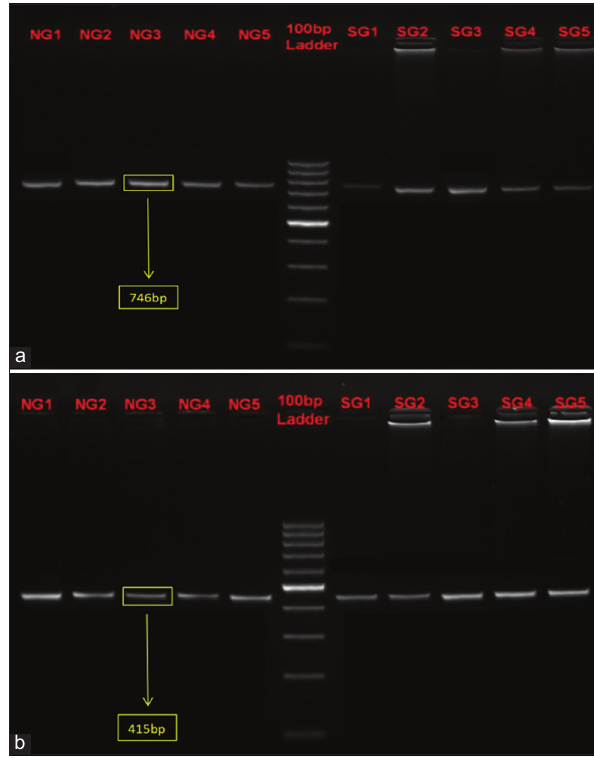
Table-1. Furthermore, the molecular definitions of